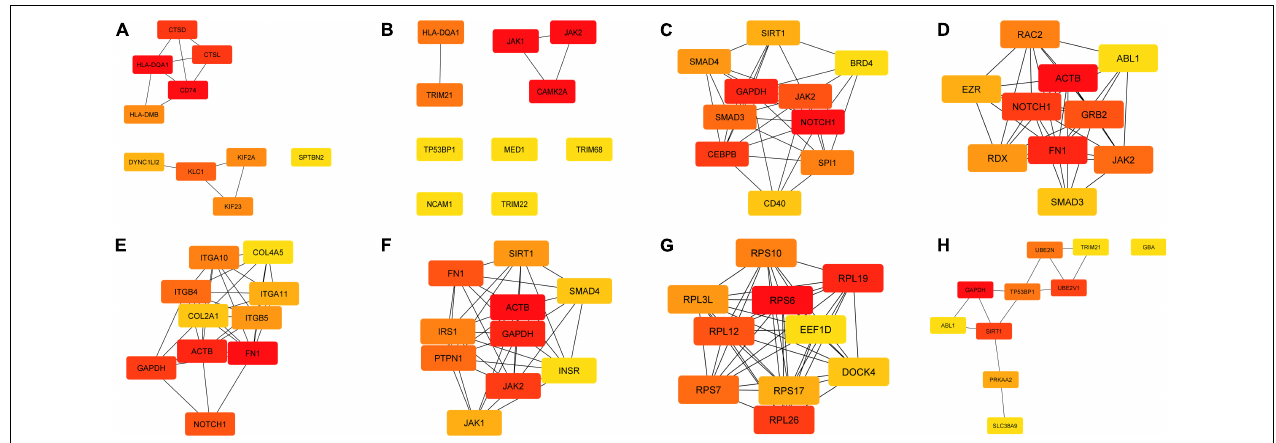
FIGURE 3 | Hub genes in each of the cluster terms identified from the enriched biological functions in the head kidney of Atlantic salmon smolts fed the MPLE supplemented diet. The principal cluster shows the ten-hub genes and the closest neighbor’s genes for each network. The color intensity from yellow to red (i.e., yellow, orange, red) represents the degree of the hub gene (i.e., the relevance degree) in each network, being red those most relevant hub genes. (A) Antigen processing and presentation of peptide antigen via MHC class II. (B) Interferon-gamma-mediated signaling pathway. (C) Regulation of I-kappaB kinase/NF-kappaB signaling. (D) Leucocyte activation involved in immune response. (E) Cytoskeleton organization. (F) Regulation of cellular protein metabolic process. (G) Cellular biosynthetic process. (H) Autophagy.